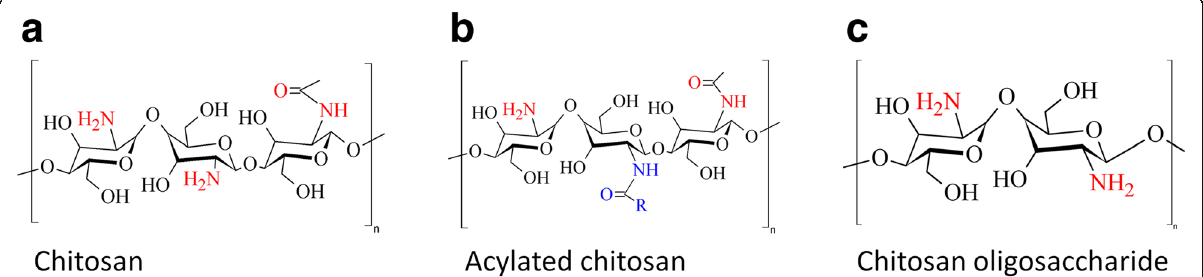
Fig. 1 Chemical structure of a chitosan, b acylated chitosan, and c chitosan